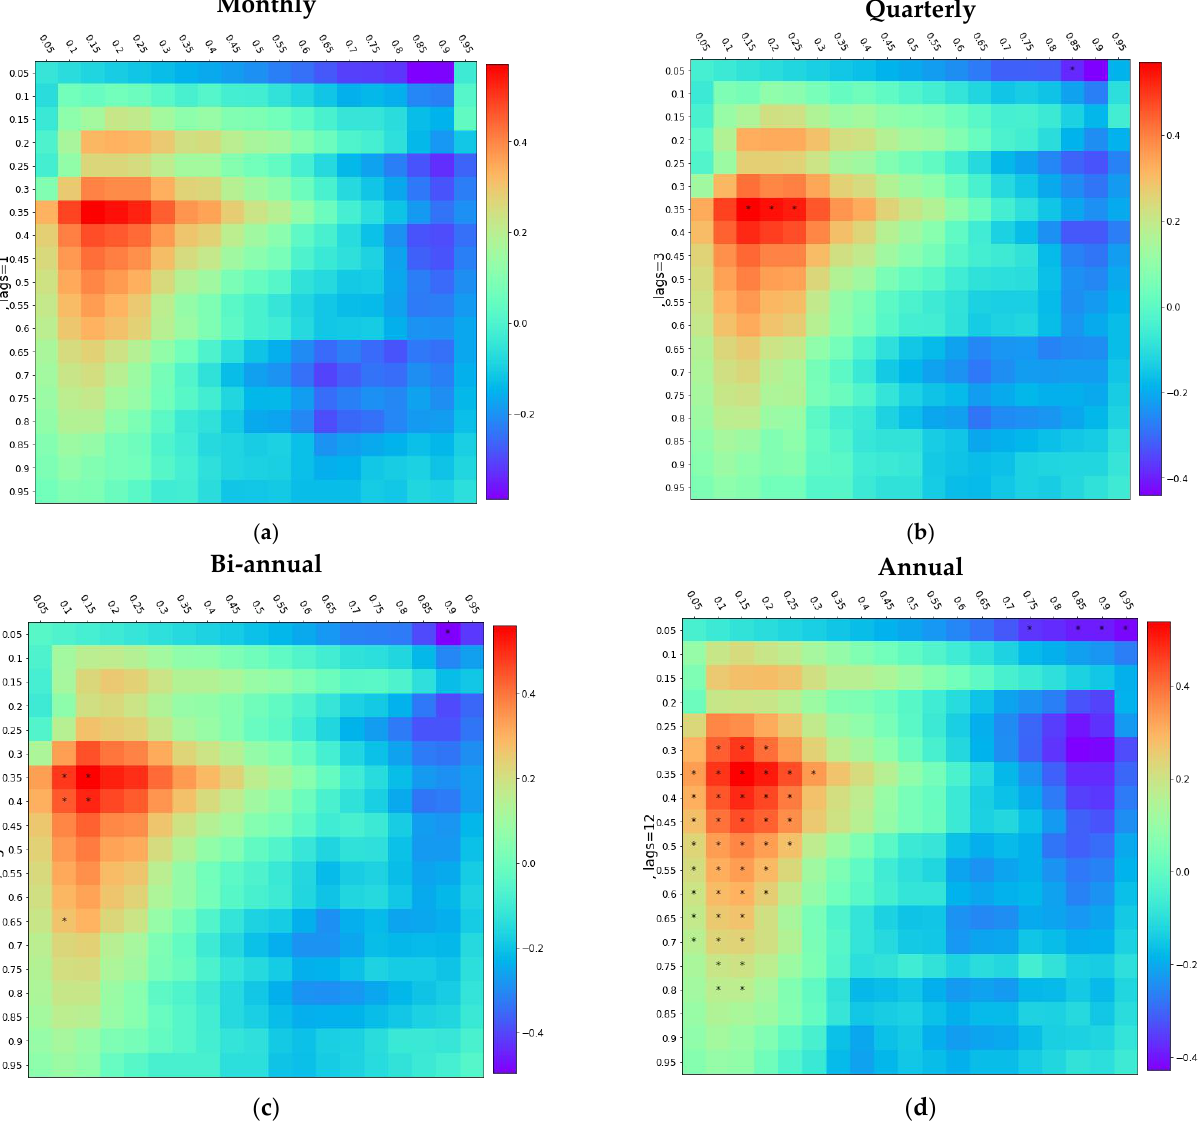
Figure 2. Effect of USA’s geopolitical risks ( UGPR ) on mineral import ( MI ) in short (monthly ( a ) and quarterly ( b )), medium (bi-annual) ( c ) and long (annual) ( d ) memories. Notes: * shows the significance level. 0.95 depicts the highest bullish scenario, and 0.05 shows the bearish state for both the UGPR and MI demand. The deep blue spectrum exhibits a solid negative consequence, while the deep red range portrays the strong positive influence of the UGPR on MI . Besides, light green and red colors display a moderately positive relationship between UGPR and MI .